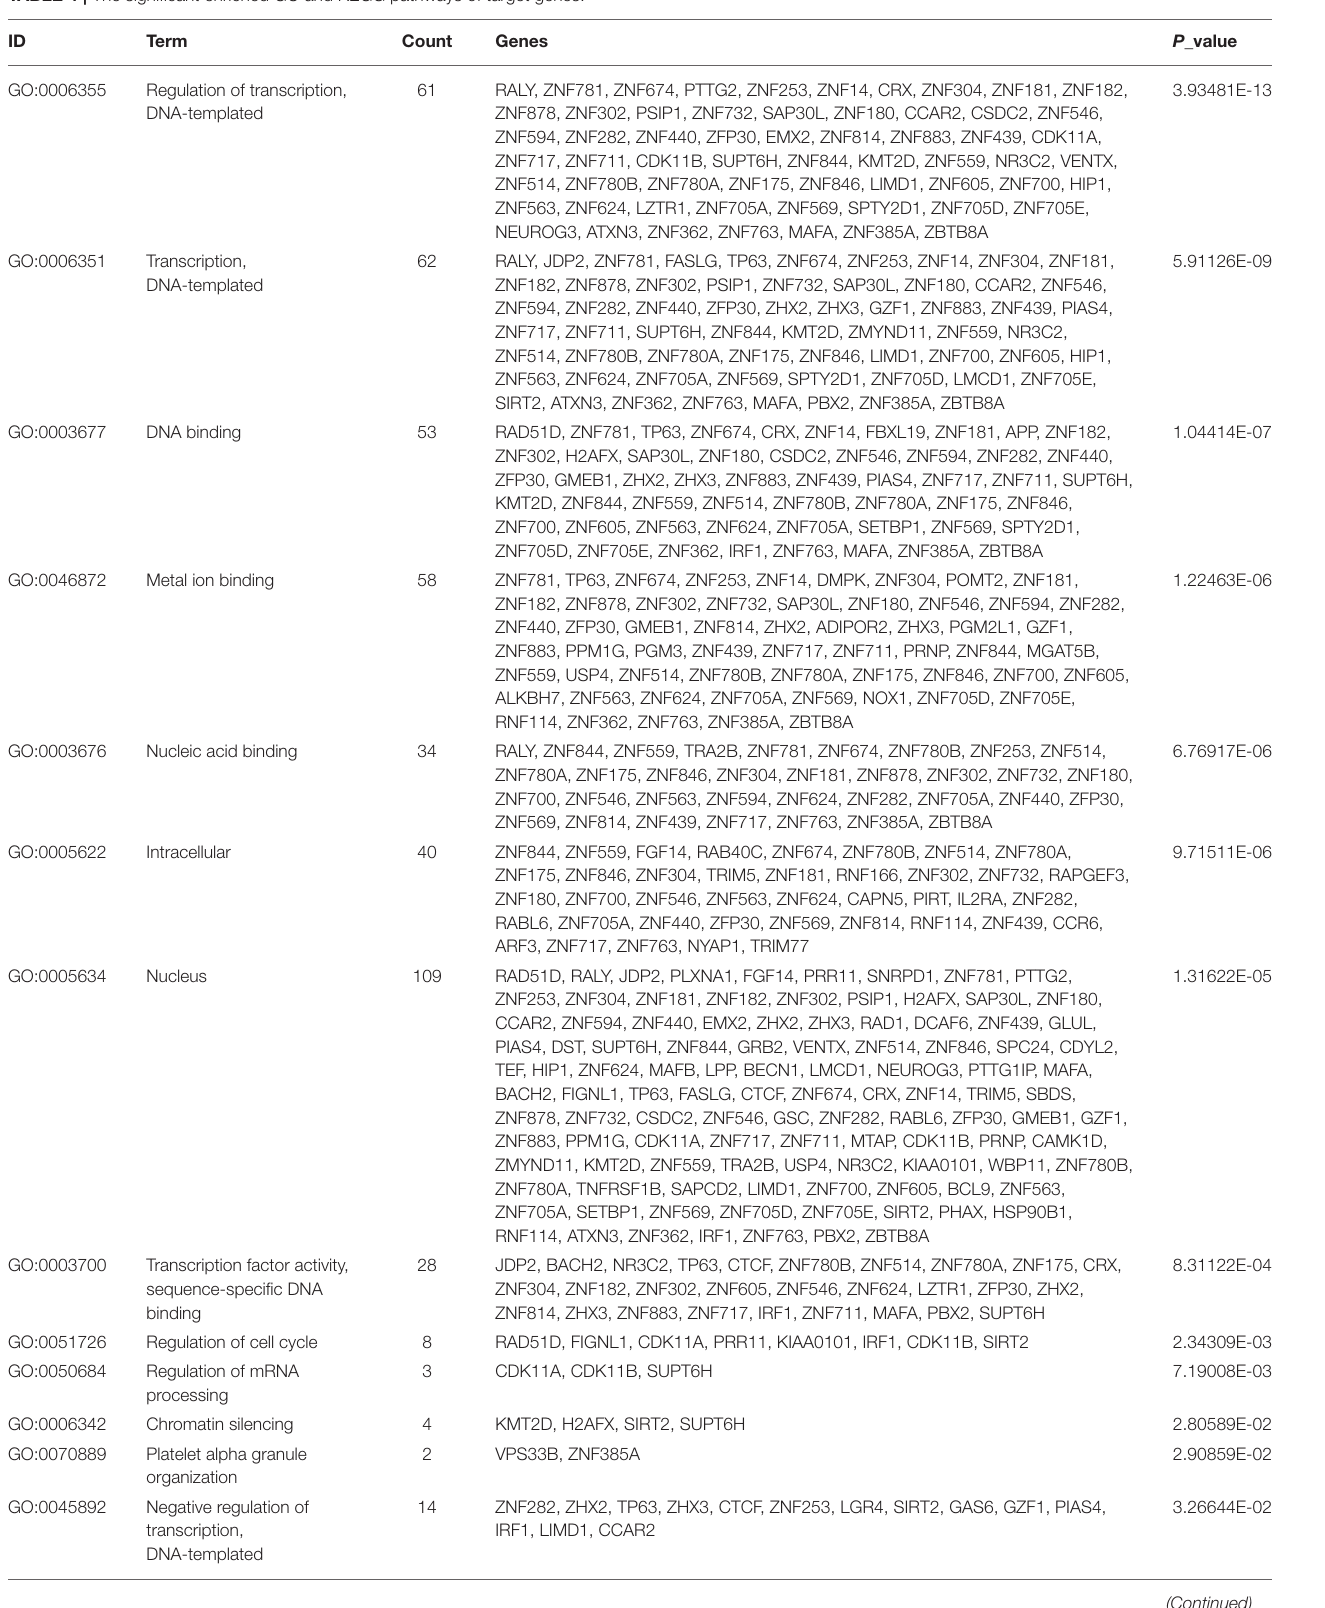
TABLE 4 | The significant enriched GO and KEGG pathways of target